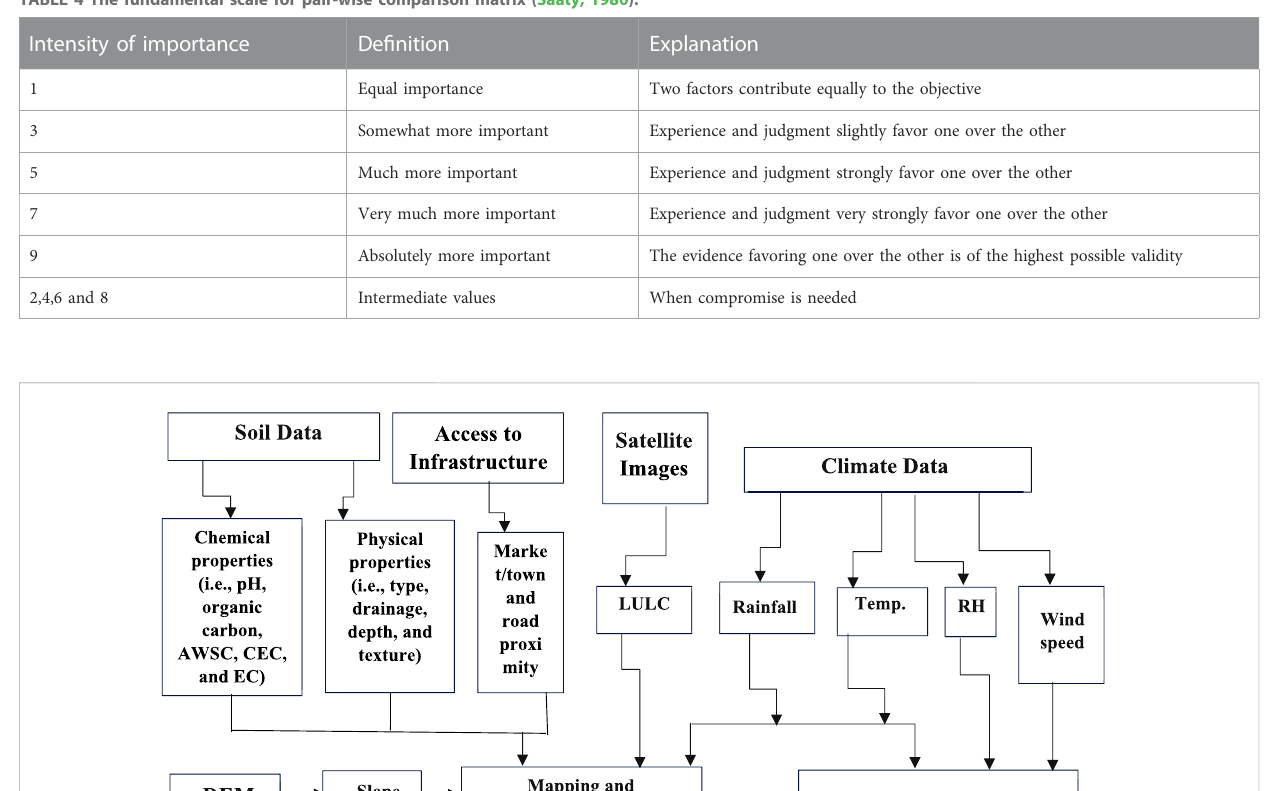
TABLE 4 The fundamental scale for pair-wise comparison matrix (Saaty, 1980).